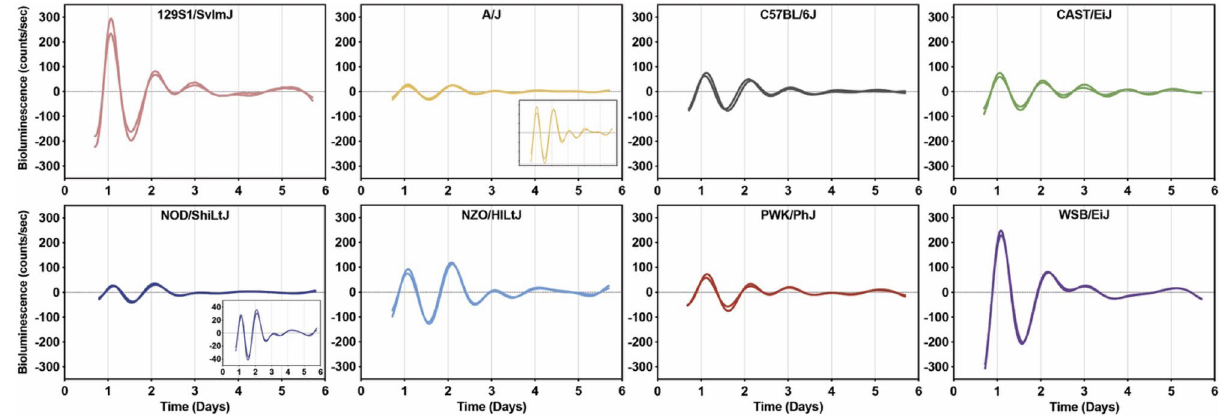
Figure 1. Representative bioluminescence recordings of ensemble Bmal1-dLuc rhythms in two individual fibroblast cultures derived from eight founder strains plotted by baseline-subtracted